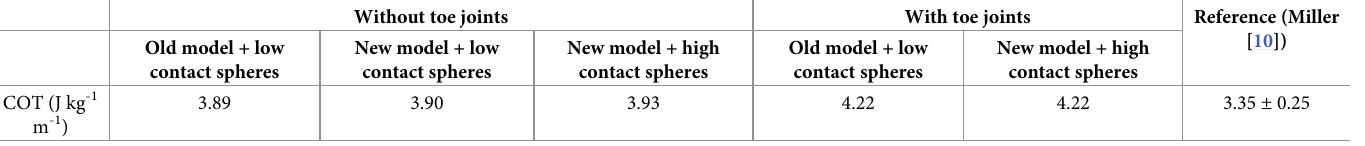
Table 1. Influence of modeling choices on the metabolic cost of transport (COT).